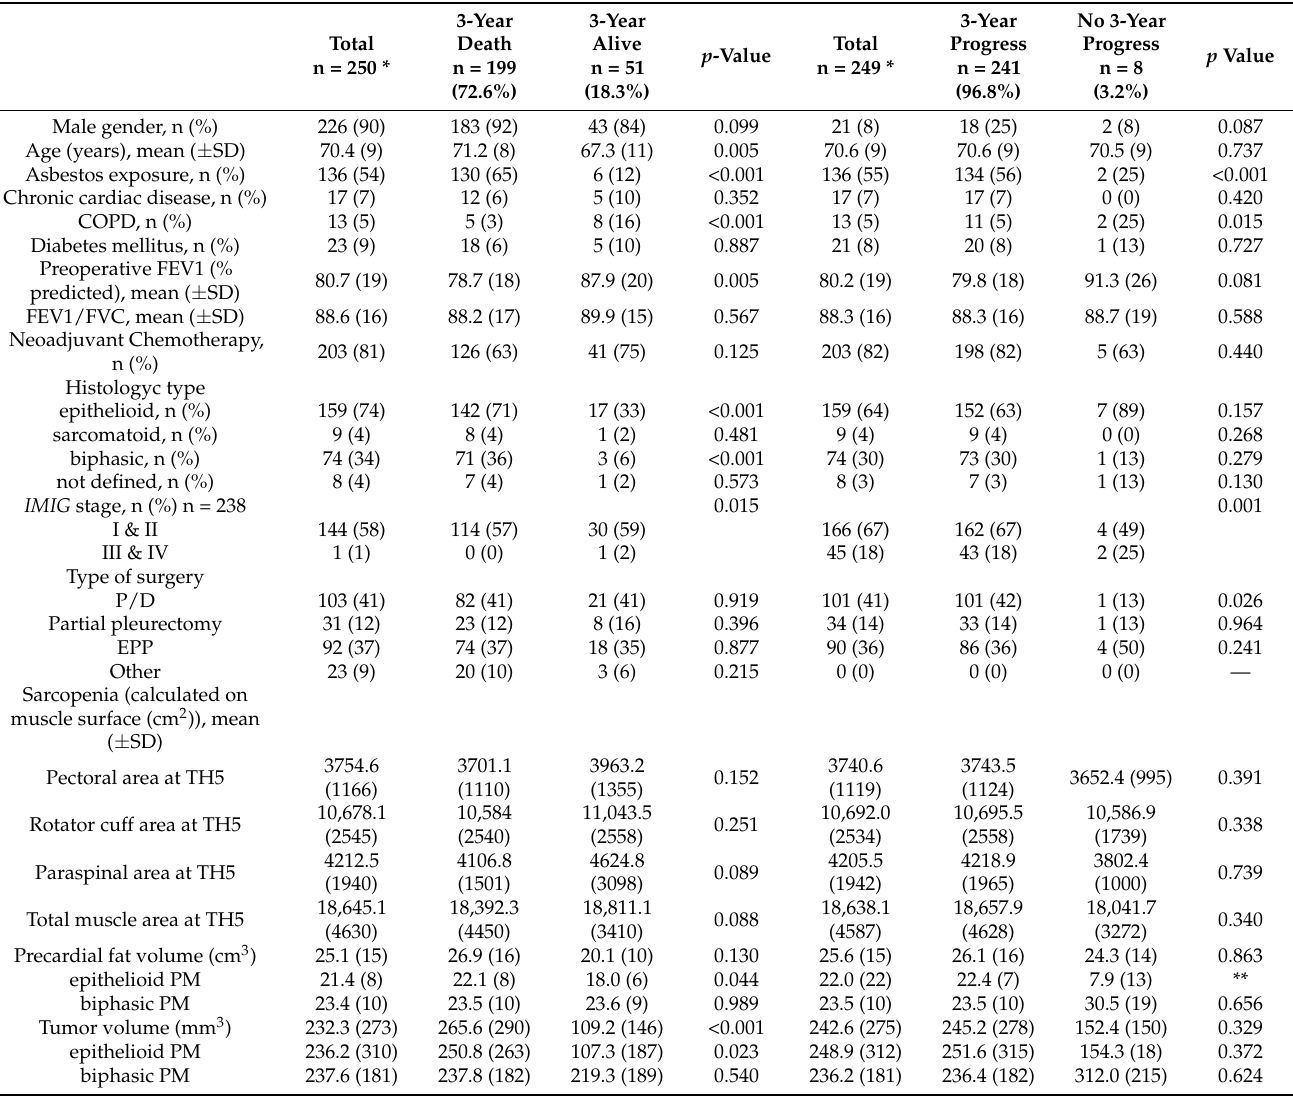
Table 2. Patient characteristics—post operative